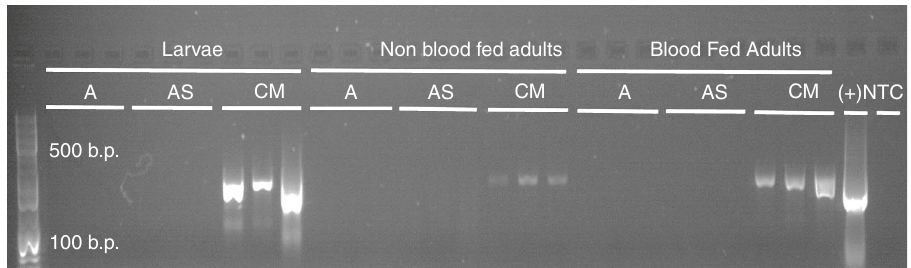
Fig. 2 PCR detection of bacterial DNA. Total DNA was extracted from axenic (A), axenic supplemented with heat-killed E. coli (AS), and colony microbiome (CM) mosquitoes at three different developmental stages (larva, non-blood fed adult, and blood fed adult). DNA from three individuals from each group was used as a template for ampli fi cation of bacterial 16S rRNA genes. A and AS mosquitoes show no visible PCR products across all developmental stages, whereas ampli fi cation products were identi fi ed in the CM mosquitoes. A positive control ( + ) containing ampli fi ed E. coli K-12 DNA and a non-template control (NTC) are also included on the gel. Ampli fi cation consisted of 30 cycles and an annealing temperature of 55 °C (see Methods)